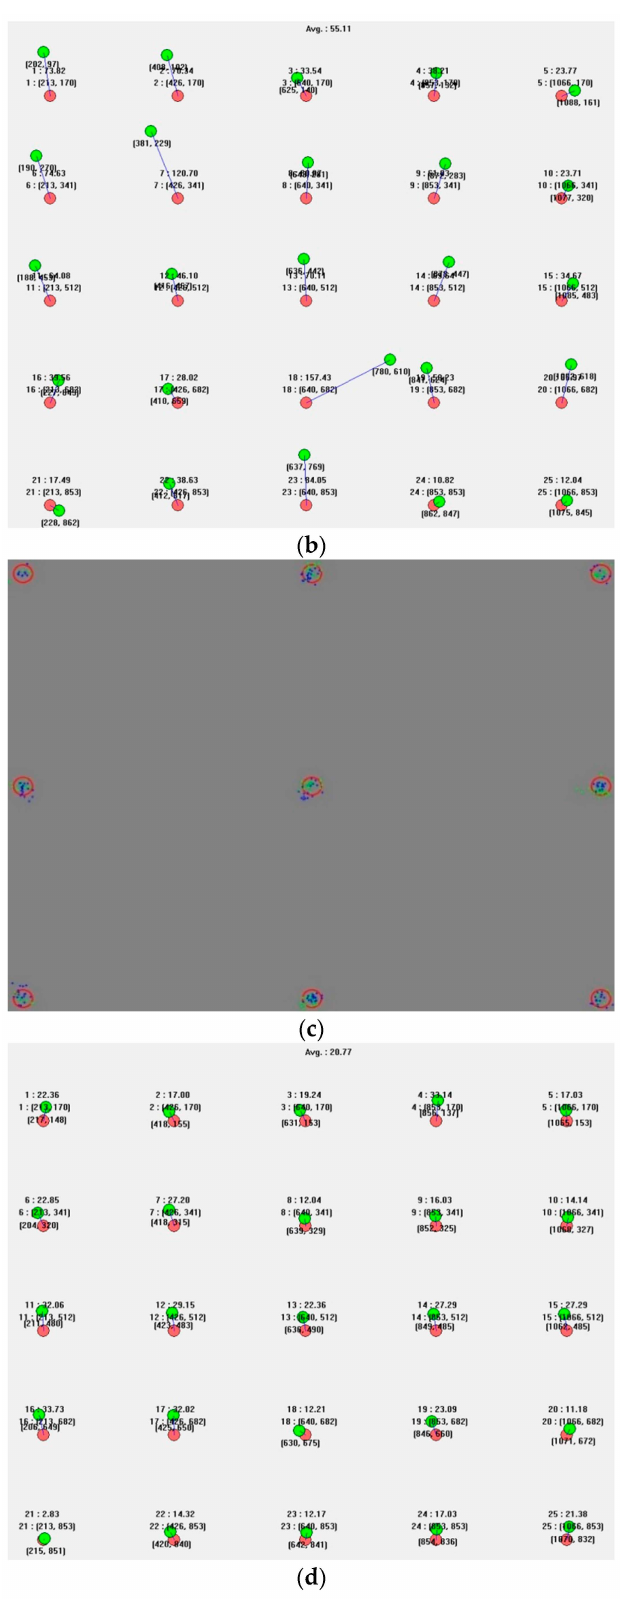
Figure 17. Results of a cross-shaped marker type expressed sequentially: ( a ) an inaccurate calibration, ( b ) an error in the gaze tracking accuracy of 1.19 ˝ ; ( c ) an accurate calibration; and ( d ) an error in the gaze tracking accuracy of 0.449 ˝